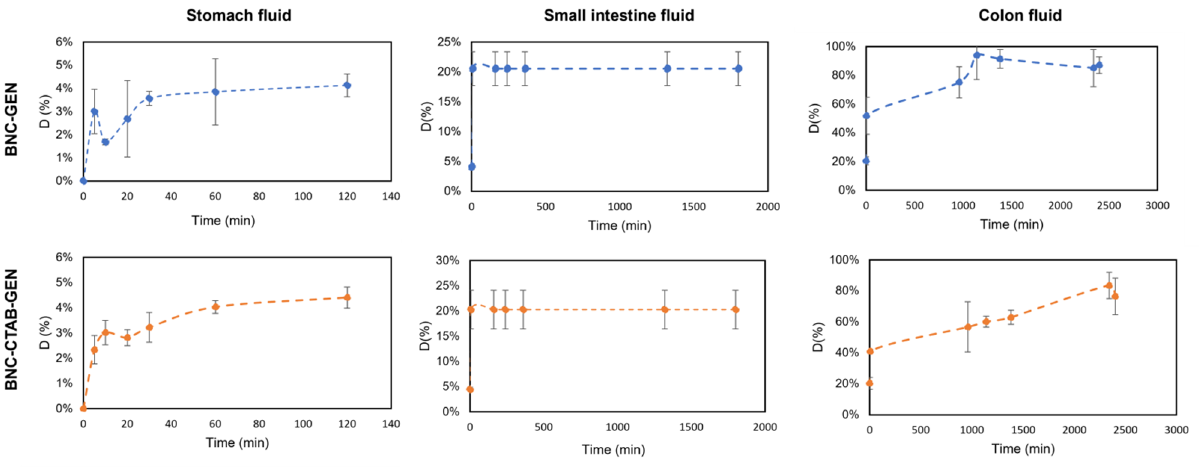
Figure 11. The release profile of genistein in gastrointestinal fluids.